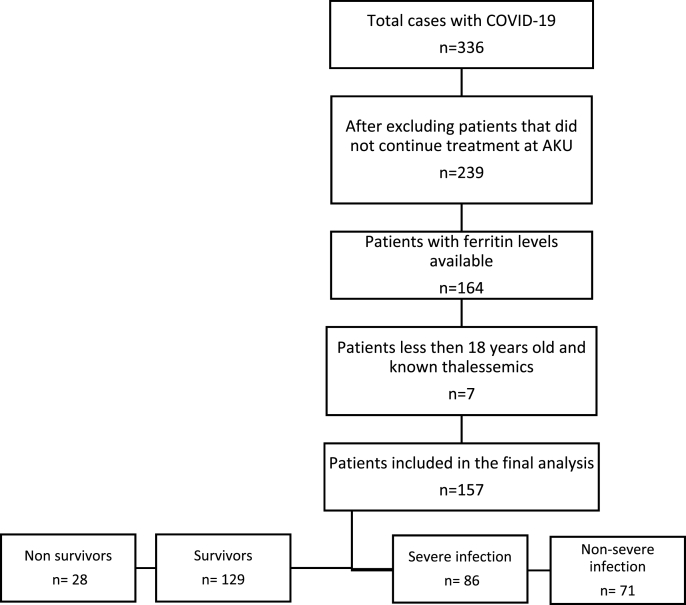
Flow diagram of data scrutiny of cases.